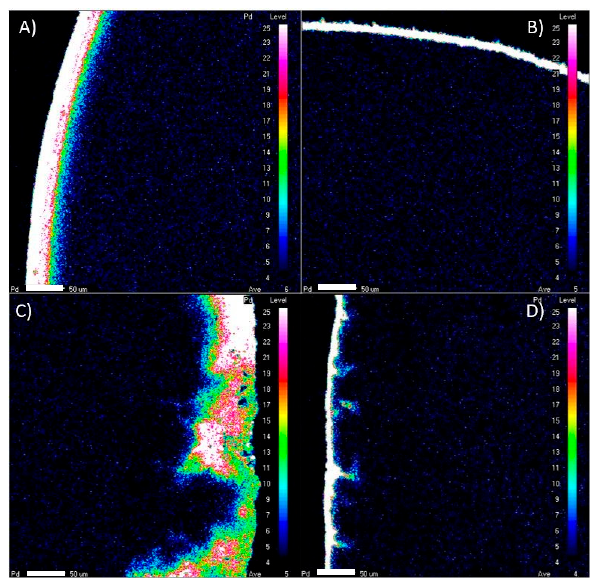
Figure 4. Microprobe cartographies of Pd on the eggshell catalysts: A ) CP-DI-N2, B ) CP-ALD, C ) RP-DI-N2, and D ) RP-ALD. Scale bar = 50 µm.